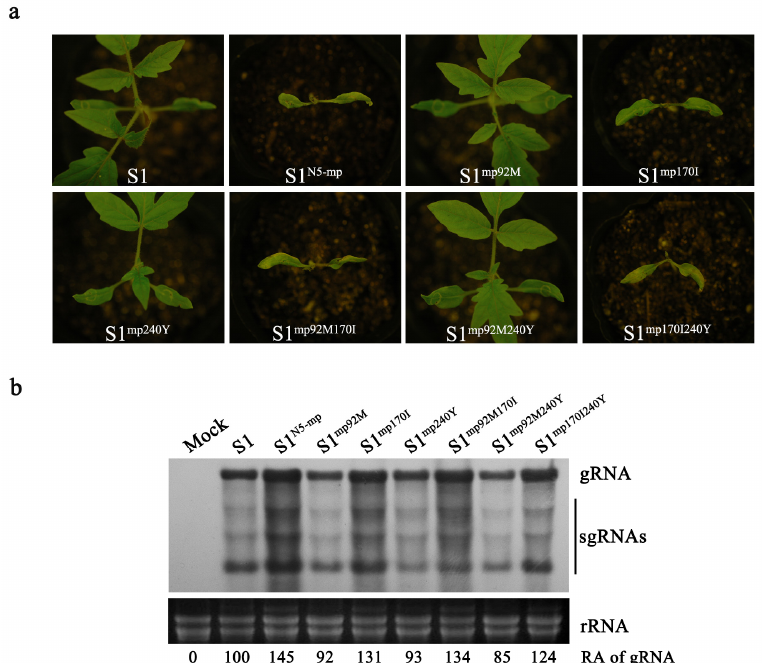
Figure 7. The S1 mutants harboring isoleucine at position 170 (170I) in its MP induced systemic necrosis in tomato plants. ( a ) Disease symptoms in tomato plants infected with S1 or its MP mu- tants, as well as S1 N5-mp , at 7 dpi. ( b ) Steady-stage levels of viral RNAs in the upper systemic leaves were analyzed using Northern blot using a DIG-labeled DNA oligonucleotide. The bands corre- sponding to genomic RNA and subgenomic RNAs of these viruses were indicated with gRNA and sgRNA, respectively. Ethidium bromide-stained ribosomal RNAs (rRNAs) were used to assess relative loading amounts of RNA samples. Relative accumulation levels of gRNA are shown